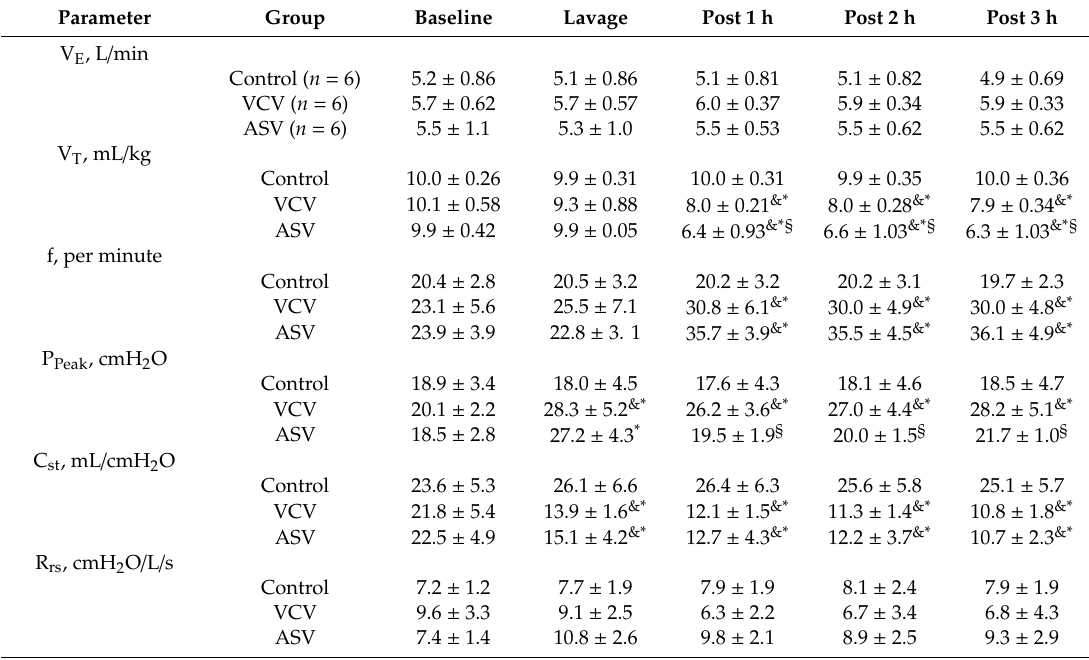
Table 2. Respiratory parameters and lung mechanics in animal